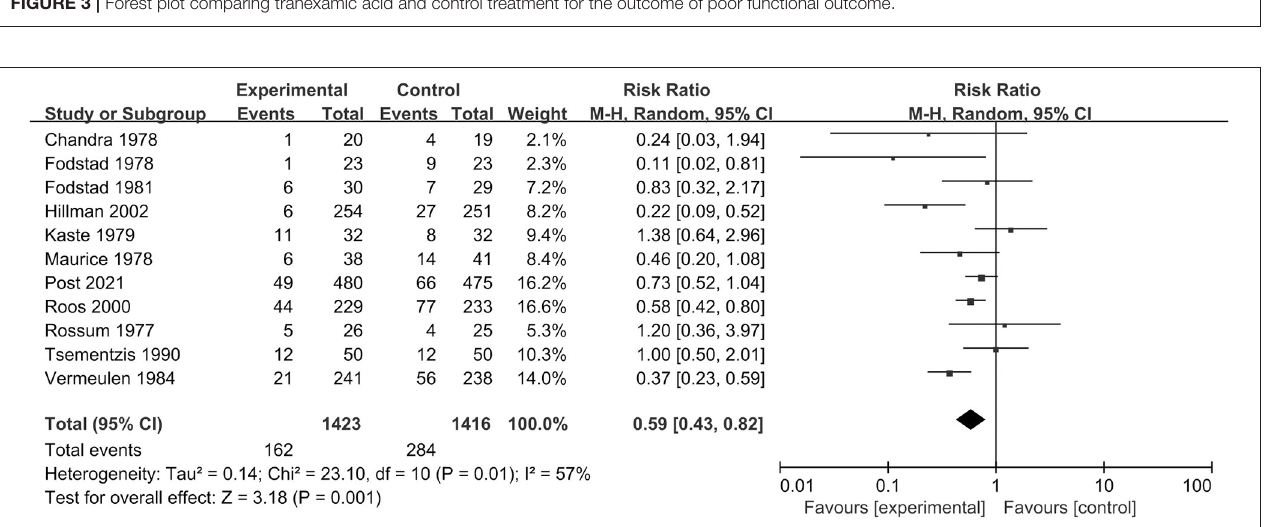
FIGURE 4 | Forest plot comparing tranexamic acid and control treatment for the outcome of